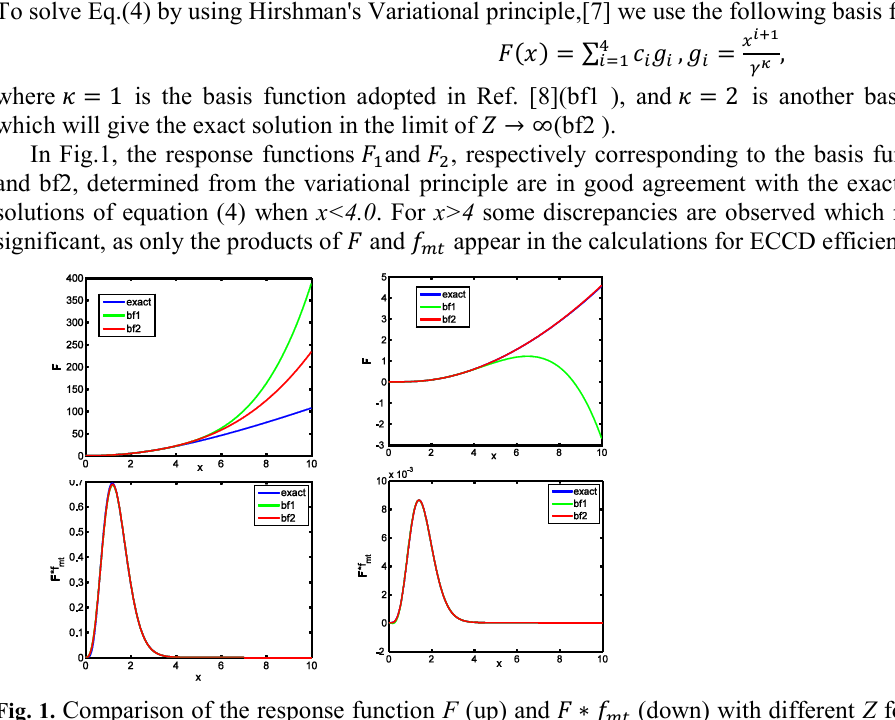
Fig. 1. Comparison of the response function F (up) and (down) with different Z for , . left: , right: